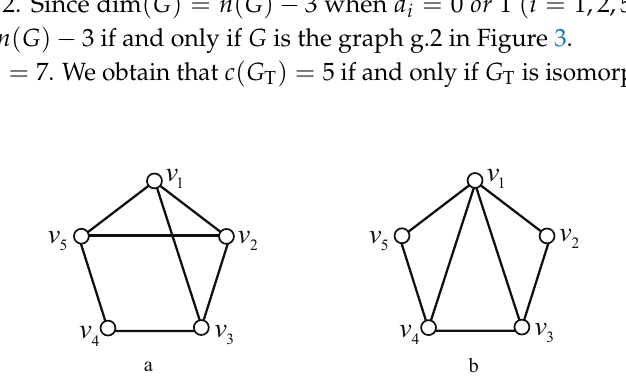
Figure 8. Graphs of d ( G ) = 2, n ( G ) = c ( G ) = 5 and | E ( G ) | = 7. For a , there are two edges without common vertices in C 5 ; for b , there are two edges with a common vertex in C 5